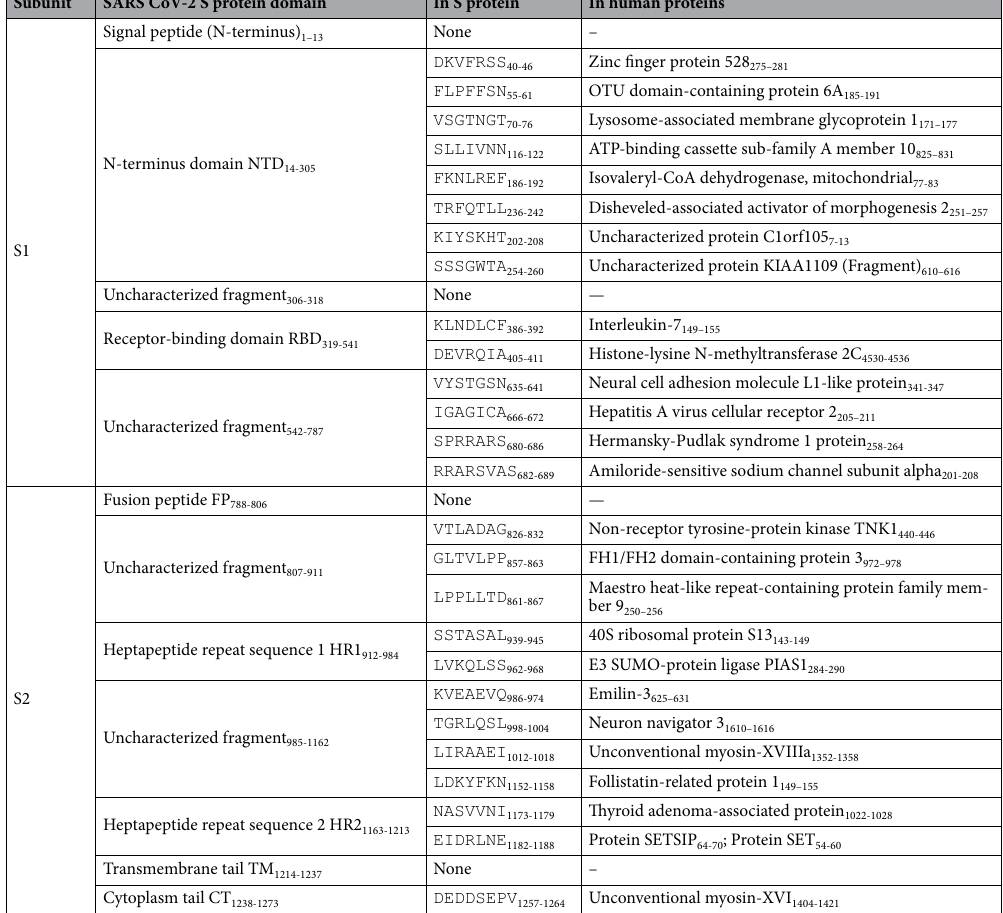
Table 1. Localization of homologous 7-/8-mers in the S protein and human proteins.